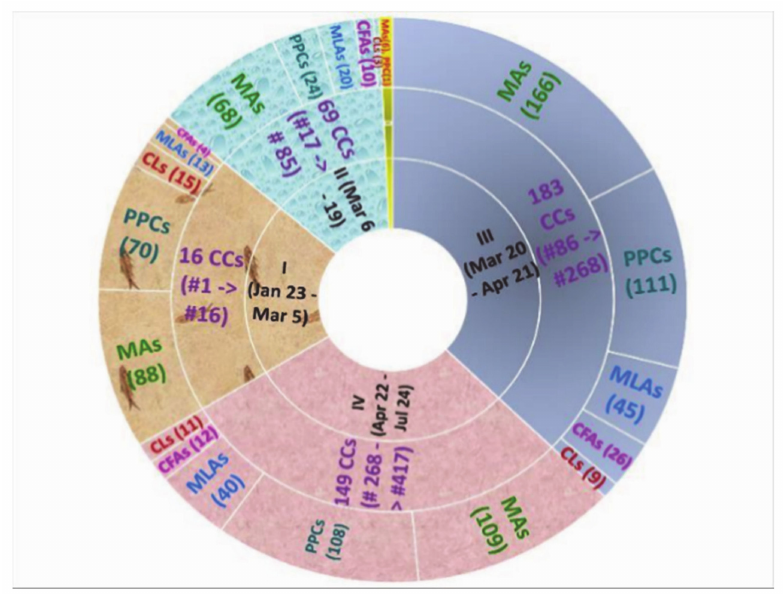
Figure 4. A total of 959 COVID-19 PDs classified by agency groups and timeframe (as of 24 July 2020).